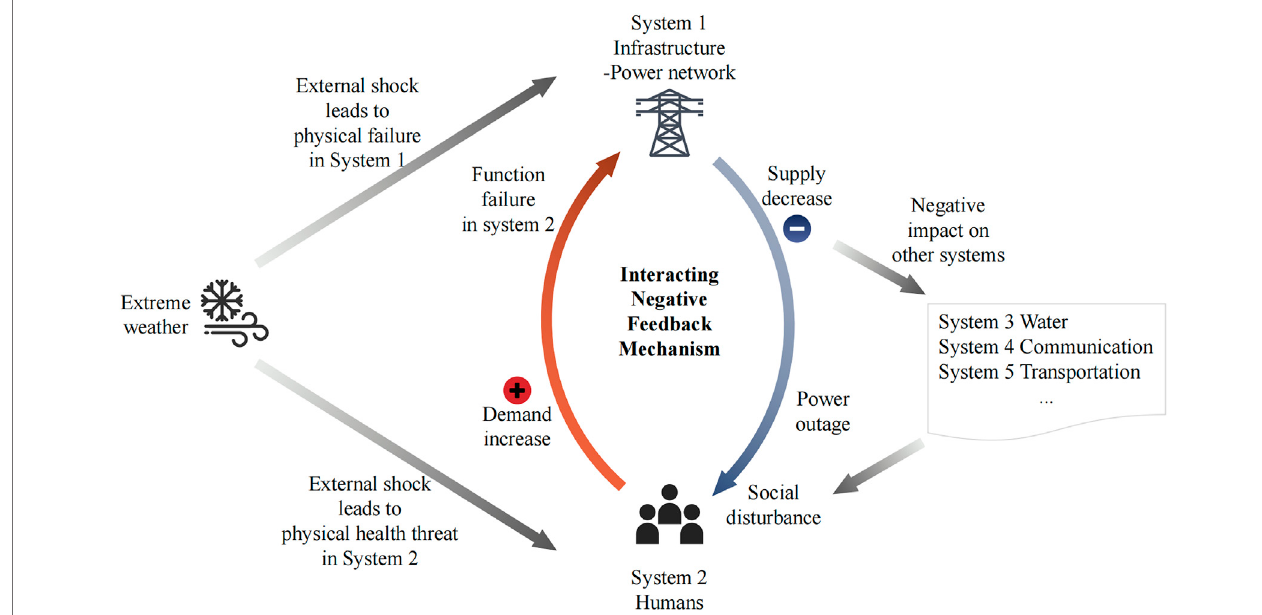
FIGURE 7 | An interacting negative feedback